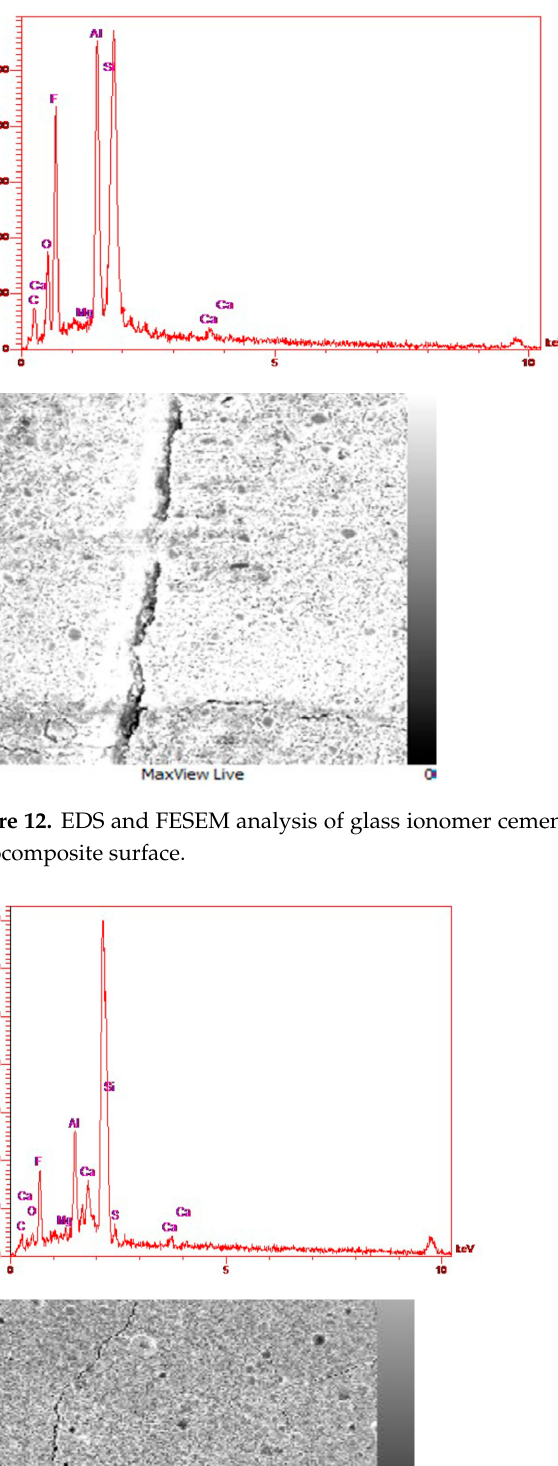
Table 2. Comparison of data with other researchers. Group